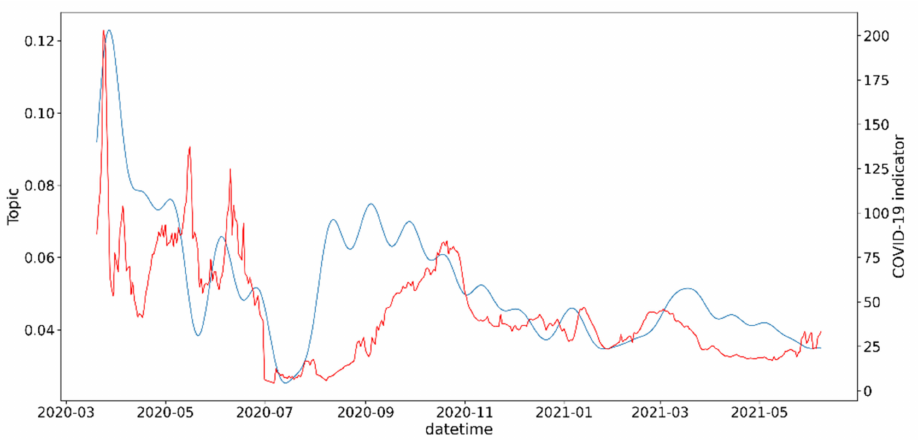
Figure A1. COVID-19 indicator—Tests per case. Topic—Case, Register, Coronavirus, Infection, Coronavirus_infection, Kazakhstan, Infection.